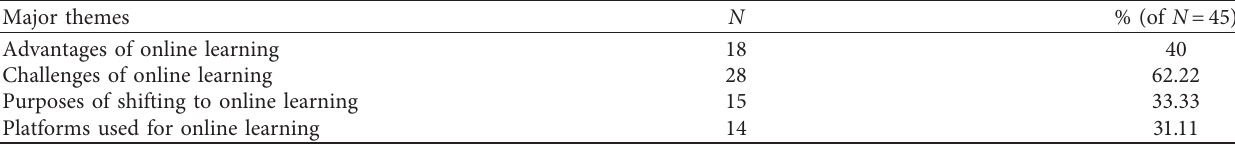
Table 2: Pedagogical trends during COVID-19.